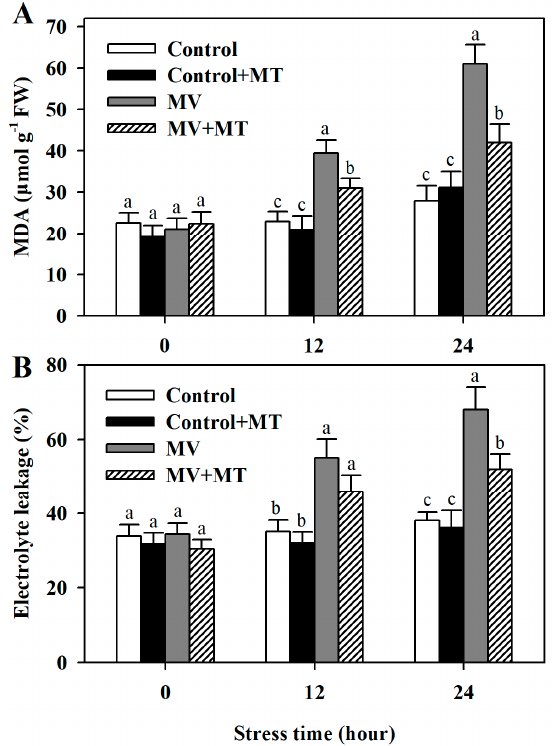
Figure 3. Alteration of lipid peroxidation and membrane stability as affected by melatonin in poplar leaf discs under MV stress. ( A ) MDA content; ( B ) Electrolyte leakage. Poplar leaf discs were pretreated with 150 µ M melatonin in the dark for 12 h, and then, leaf discs were exposed to 50 µ M methyl viologen in the light for 24 h. Leaf discs were collected at 0, 12 and 24 h following MV treatment. The values presented are means ± SDs ( n = 3). Different letters indicate significant difference at p < 0.05 among treatments.